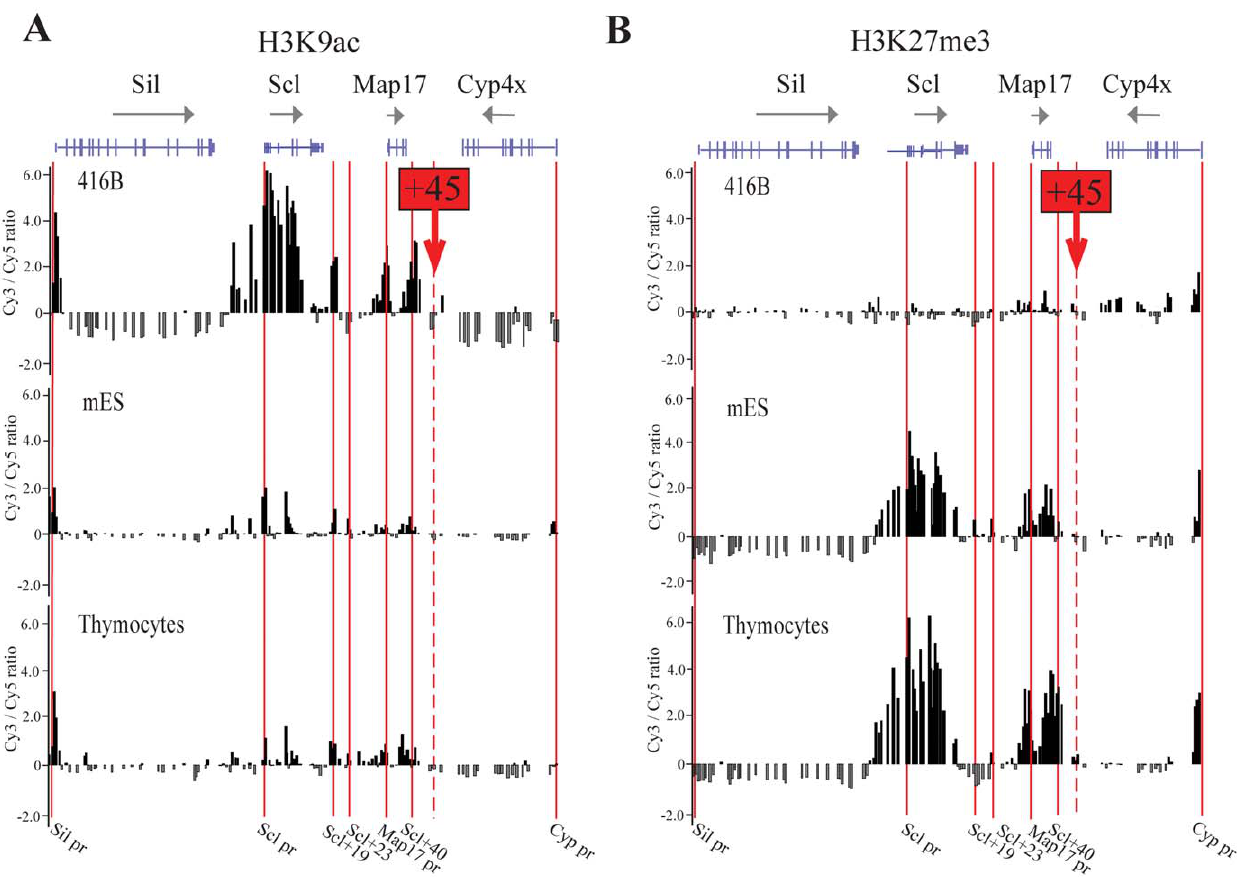
Figure 2. ChIP-chip profiles mapping of H3K9ac (A) and H3K27me3 (B) across 150 kb of the extended Scl locus in 3 cell types, 416B (mouse haematopoietic progenitor cells), mouse embryonic stem cells (mES) and primary mouse thymocytes. The location of the 4 genes at the locus are represented at the top of the figure (Sil, Scl, Map17 and Cyp4x) with direction of transcription indicated by the arrows and translated and untranslated exons represented by wide and narrow bars respectively. The location of known key regulatory elements is indicated by the red bars (Sil promoter, Scl promoter, Scl + 19, Scl + 23, Map17 promoter,Scl + 40 and Cyp promoter), and the location of the putative + 45 element is indicated with a dashed red line. Representative experiments showing fold enrichment over non-enriched input plotted (log 2 ) against genomic position. In the cell types studied, the + 45 element is located at a boundary between chromatin domains carrying transcriptionally active and/or repressive histone marks, while the H3 proteins at the + 45 element itself are neither acetylated at H3K9 nor methylated at H3K27.